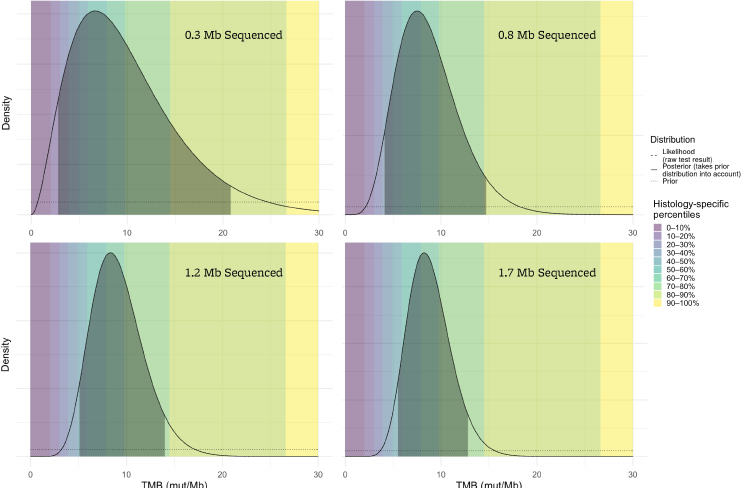
Figure 2. The accuracy of the TMB result is highly dependent upon the number of megabases sequenced. If very few megabases are sequenced (top left panel), the range of plausible true TMB values (indicated by the shaded areas of the plots) given the assay result is very broad, while results from larger sequencing assays (such as the bottom right) are more